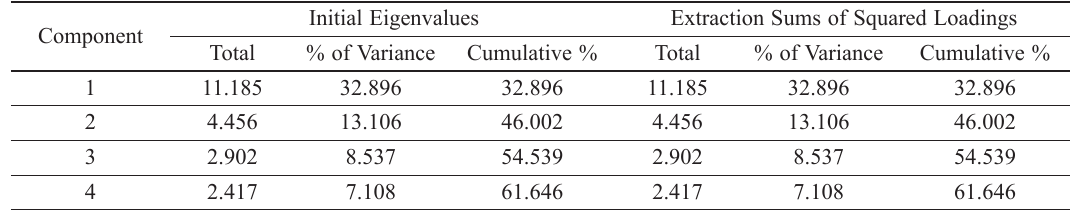
Table 5. The variance explained by extracted major components